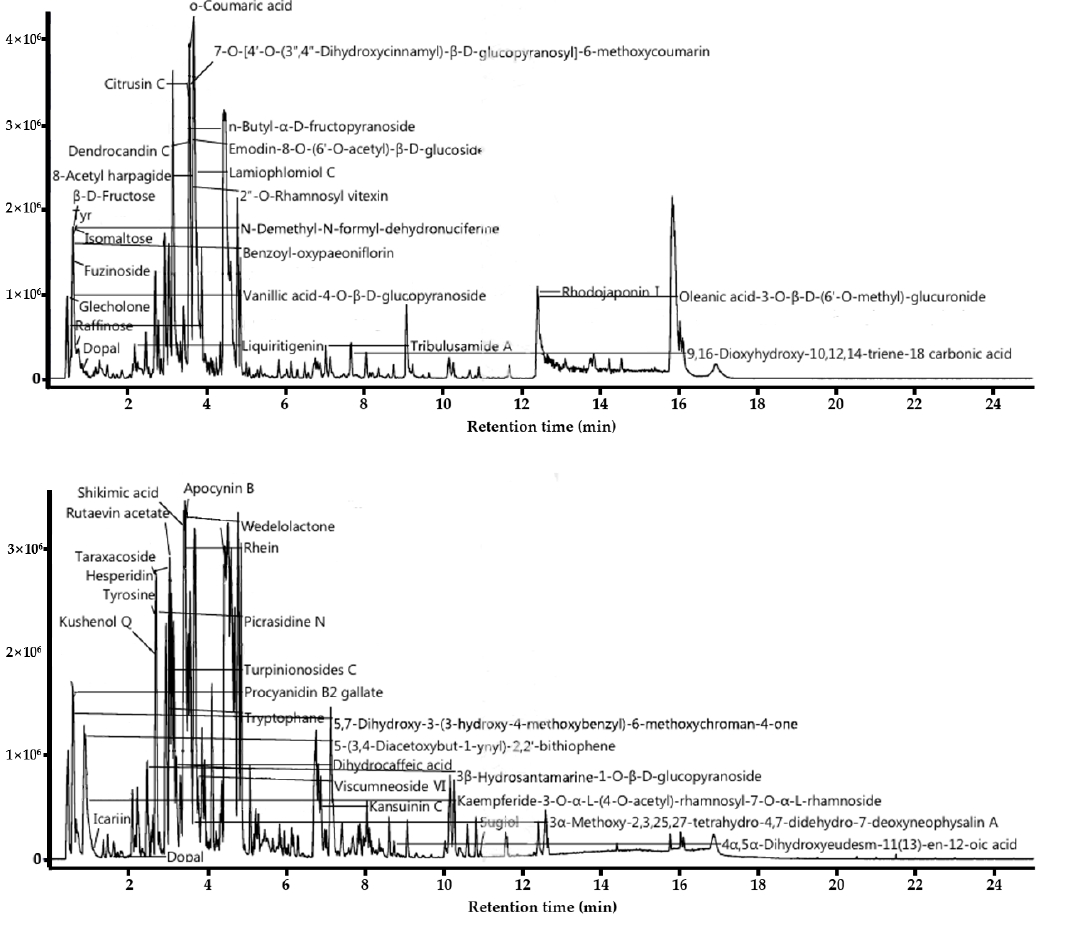
Figure 1. Functional components of L. barbarum leaf extract. Positive ( upper ) and negative ( down ) base peak intensity (BPI) chromatograms of the L. barbarum leaf was measured using ultra-performance liquid chromatography coupled with electrospray ionization/quadrupole-time-of-flight mass spectrometry.